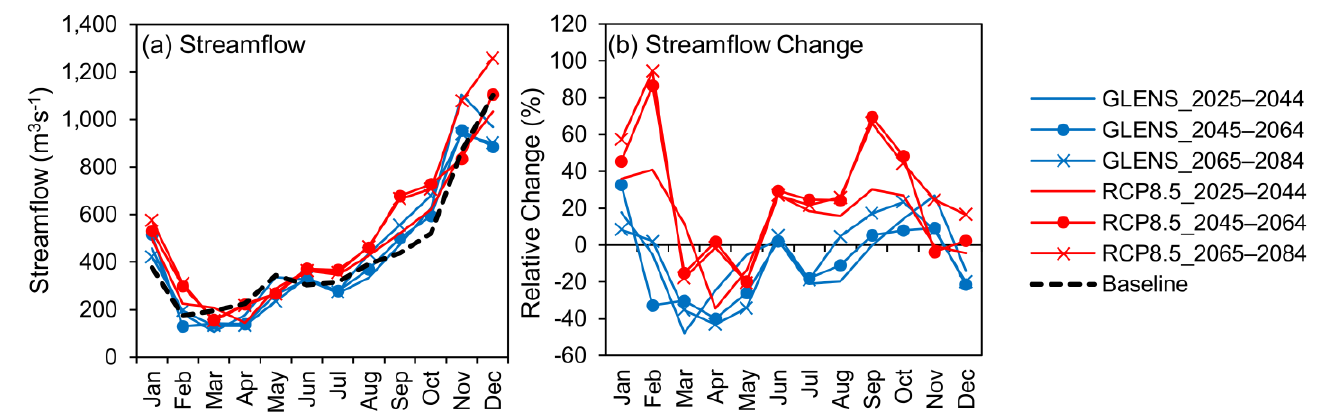
Figure 9. Climatology ( a ) and relative changes ( b ) of the streamflow at the Jambatan Guillermard between the historical (1985 – 2004) and future periods (2025 – 2044, 2045 – 2064 and 2065 – 2084) under RCP8.5 and GLENS.